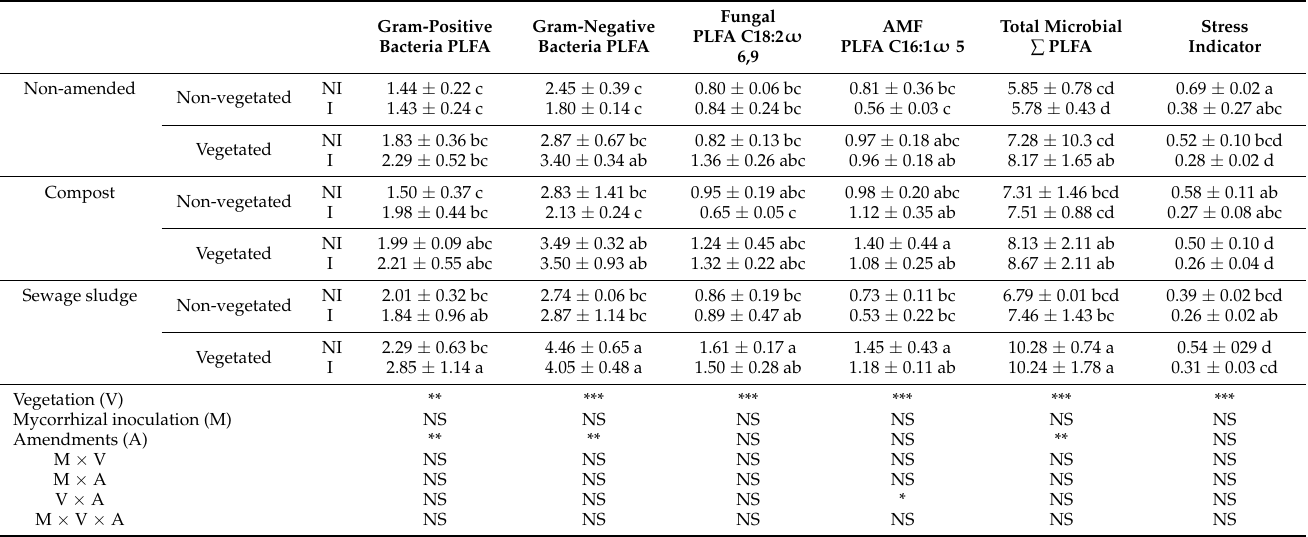
Table 3. Biomass ( µ g/g dry soil) of specific microbial groups (Gram-positive bacteria, Gram-negative bacteria, saprotrophic fungi, and AMF), total microbial biomass, and stress indicator in the different soil treatments (n = 3).